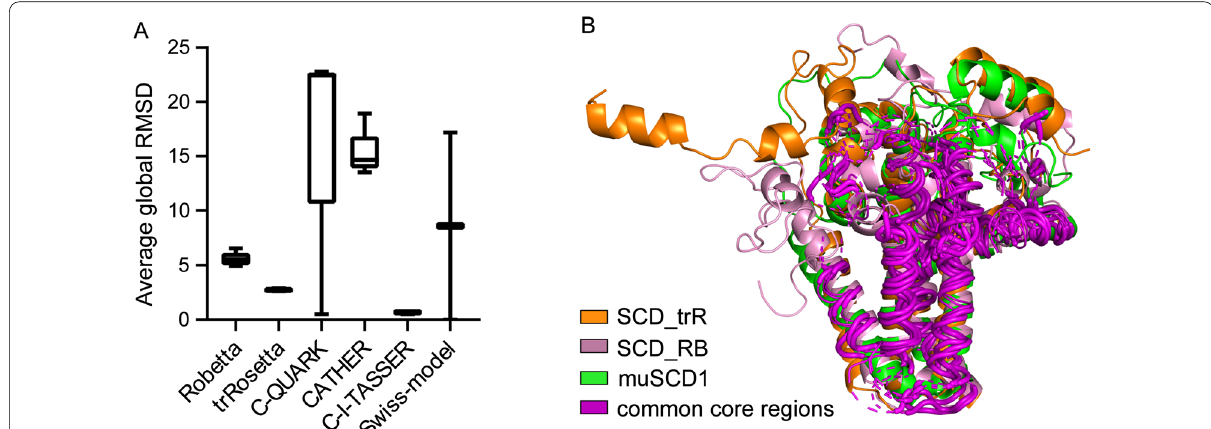
Fig. 1 Comparison between the structure of muSCD1 and models constructed using different modeling methods. A The average global RMSD between the models was constructed using the six modeling methods and the data from the crystal. B Alignment of muSCD1 and models. The models with a global RMSD < 2 Å compared with muSCD1. The purple cartoon is a common core region with three